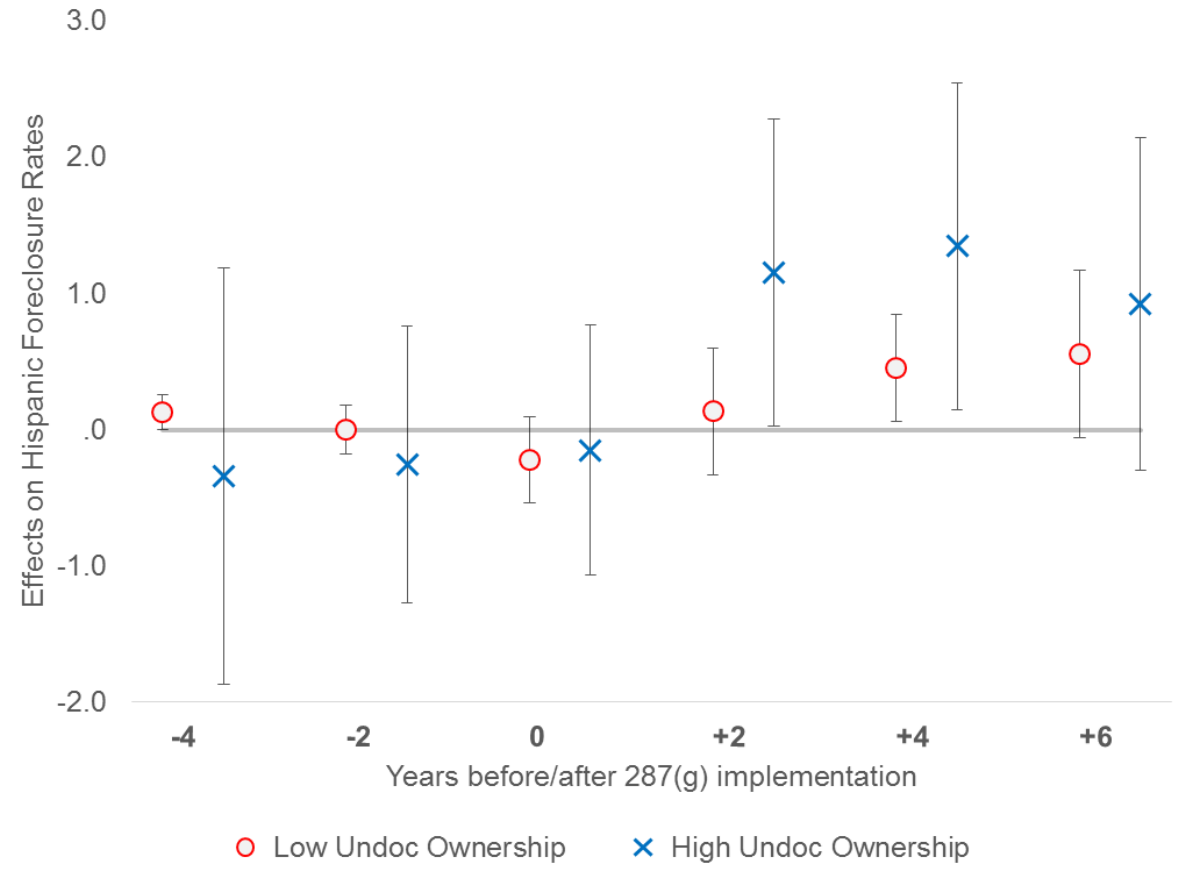
Figure 5: Effects of 287(g) on Hispanic foreclosure rates, by % of undocumented in owner-occupied